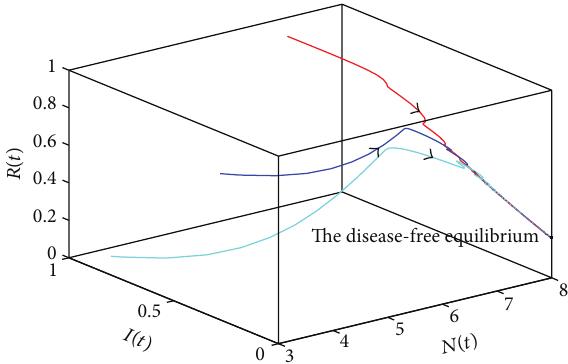
Figure 1: The disease-free equilibrium 𝐸 0 is locally asymptotically stable. Variation of infective population 𝐼(𝑡) and recovered popula- tion 𝑅(𝑡) with total population 𝑁(𝑡) .